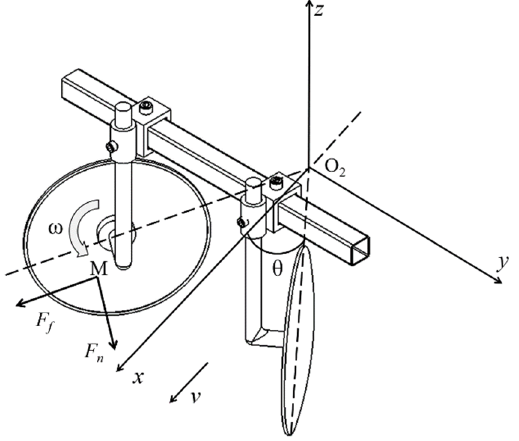
Figure 6. The dynamic analysis of a soil particle. The displacement of the soil particle in the x , y , and z directions is obtained by Formula (2) integrated